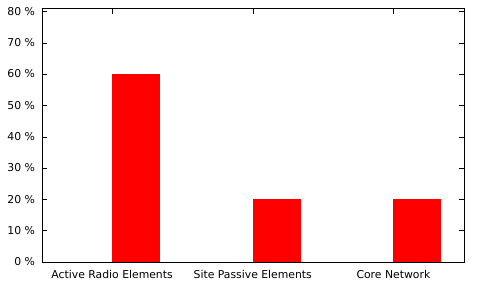
Figure 5. Mobile network deployment investment